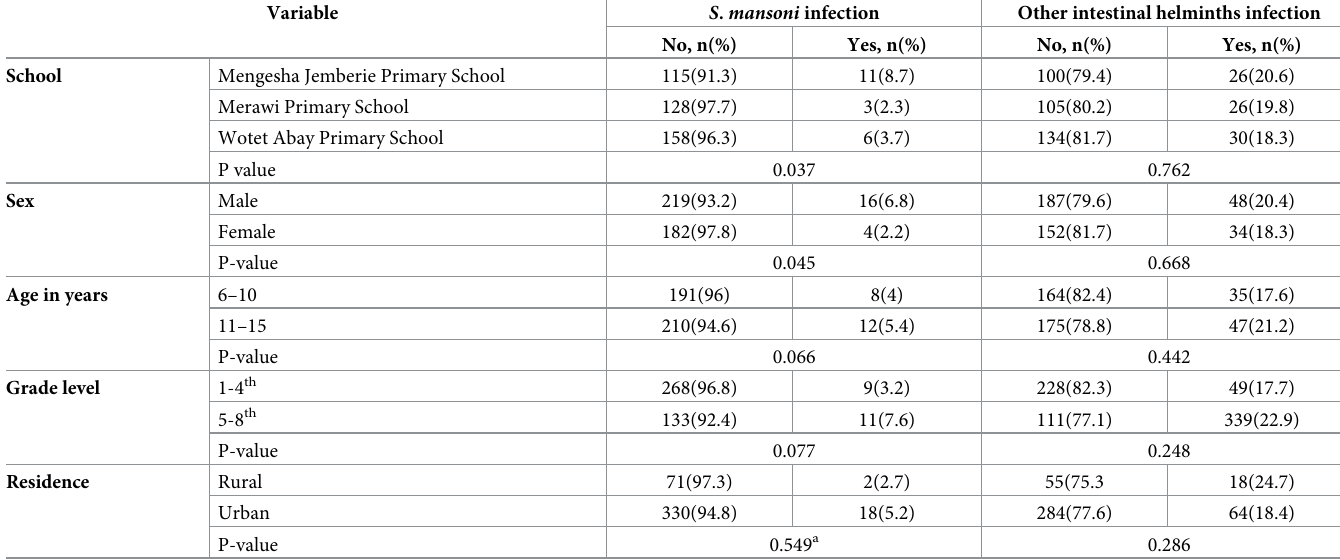
Table 3. Distribution of S . mansoni and other intestinal helminths among study participants with respect to socio-demographic variables, northwest Ethiopia, N = 421.